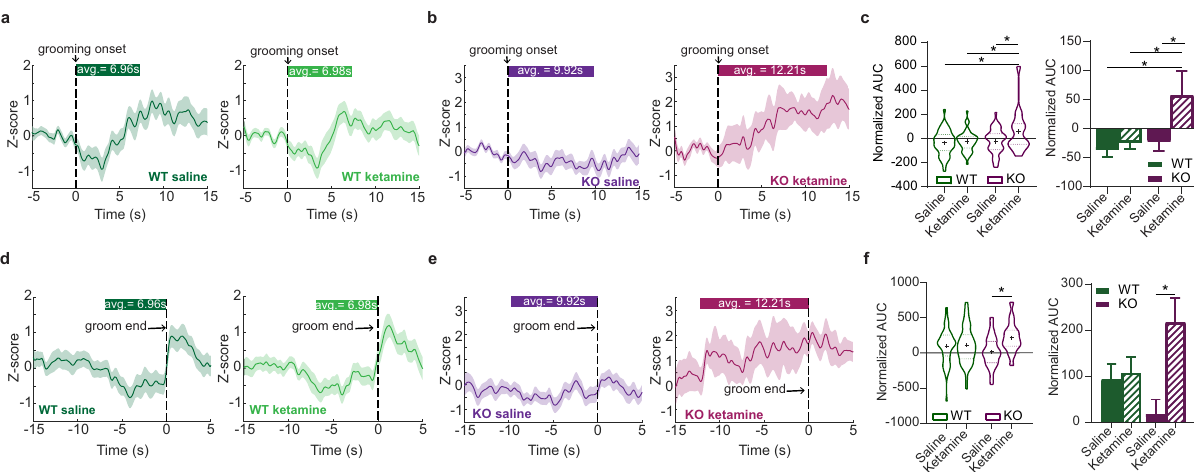
Fig. 4 Additional effects of ketamine on fronto-striatal circuit activity. a PETHs of averaged z-score signals aligned to grooming onset (green bar represents average length of grooming epoch) after saline (left, N = 51 groom epochs from 11 WTs) and ketamine injections (right, N = 55 groom epochs from 11 WTs) in WT animals. b PETHs of averaged z-score signals aligned to grooming onset in KO animals after saline (left, N = 46 groom epochs from 10 KOs) and ketamine injections (right, N = 17 groom epochs from 9 KOs). c Area under the curve (AUC) quanti fi cation for each grooming epoch shown as truncated violin plot (left) and bar graph (right). Two-way ANOVA; interaction P = 0.0592, genotype P = 0.0129, drug effect P = 0.0110; Tukey ’ s multiple comparison test: WT saline vs KO ketamine P = 0.0113, WT ketamine vs KO ketamine P = 0.0313, KO saline vs KO ketamine P = 0.0407; WT = 51 grooming epochs with saline and 55 grooming epochs with ketamine from 11 animals, KO saline = 46 grooming epochs from 10 animals, KO ketamine = 17 grooming epochs from 9 animals). d PETHs of averaged z-score signals aligned to the end of grooming in WT mice after saline (left, N = 51 groom epochs from 11 WTs) and ketamine (right, N = 55 groom epochs from 11 WTs). e PETHs of averaged z-score signals aligned to the end of grooming in KO mice after saline (left, N = 46 groom epochs from 10 KOs) and ketamine (right, N = 17 groom epochs from 9 KOs). f AUC analysis of neural signal after groom end shown as truncated violin plot (left) and bar graph (right). Two-way ANOVA: interaction P = 0.0243, genotype P > 0.05, treatment P = 0.0096; Tukey ’ s multiple comparisons: KO saline vs KO ketamine P = 0.0180). Bar graphs and Peri-event time histograms (PETHs) show means + / − SEM. Truncated violin plots end at distribution minimum and maximum, dotted lines mark 25% – 75% quartiles, cross denotes means. Source data are provided as a Source data fi le. * P <